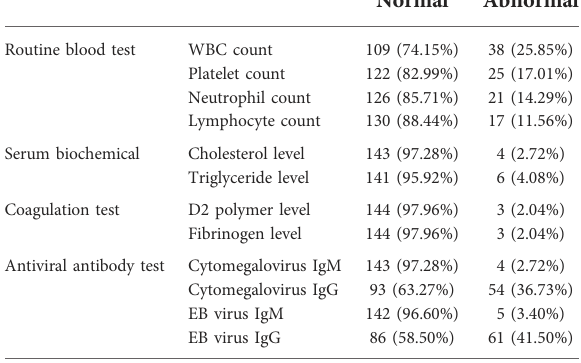
TABLE 2 Laboratory examination results of children with profound sudden sensorineural hearing loss.